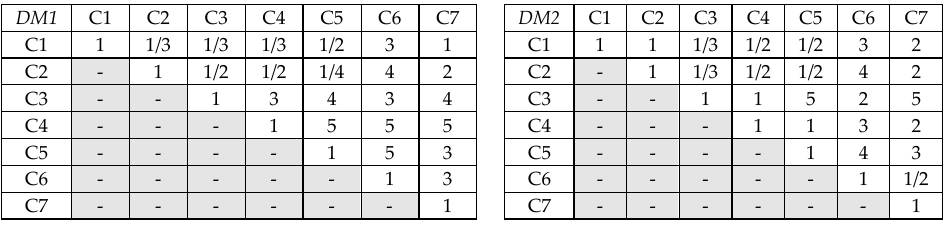
Figure 6. Results of DEMATEL application — group context .